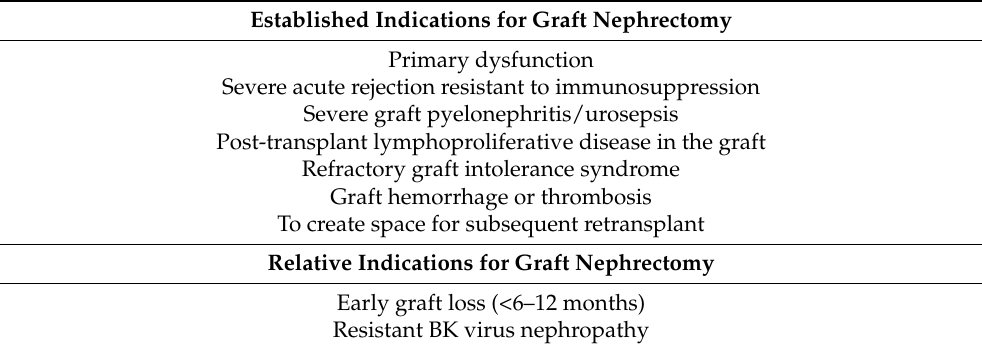
Table 2. Indications for graft nephrectomy after graft loss [6,66,67,70]. Established Indications for Graft Nephrectomy Primary dysfunction Severe acute rejection resistant to immunosuppression Severe graft pyelonephritis/urosepsis Post-transplant lymphoproliferative disease in the graft Refractory graft intolerance syndrome Graft hemorrhage or thrombosis To create space for subsequent retransplant Relative Indications for Graft Nephrectomy Early graft loss (<6–12 months) Resistant BK virus